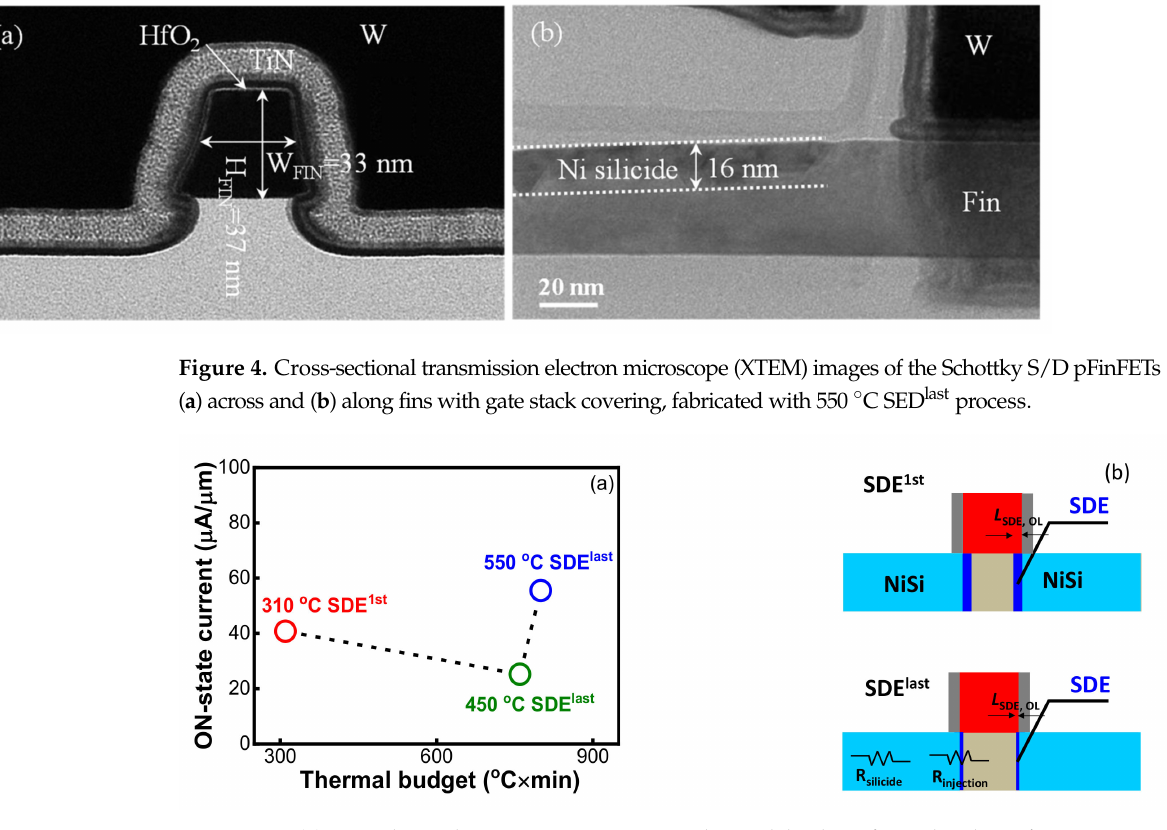
Figure 5. ( a ) I ON dependence on SDE process thermal budget for Schottky S/D pFinFETs, ( b ) Schematic of gate-to-SDE overlap ( L SDE, OL ) and R S/D component for the devices with SDE 1st and SDE last